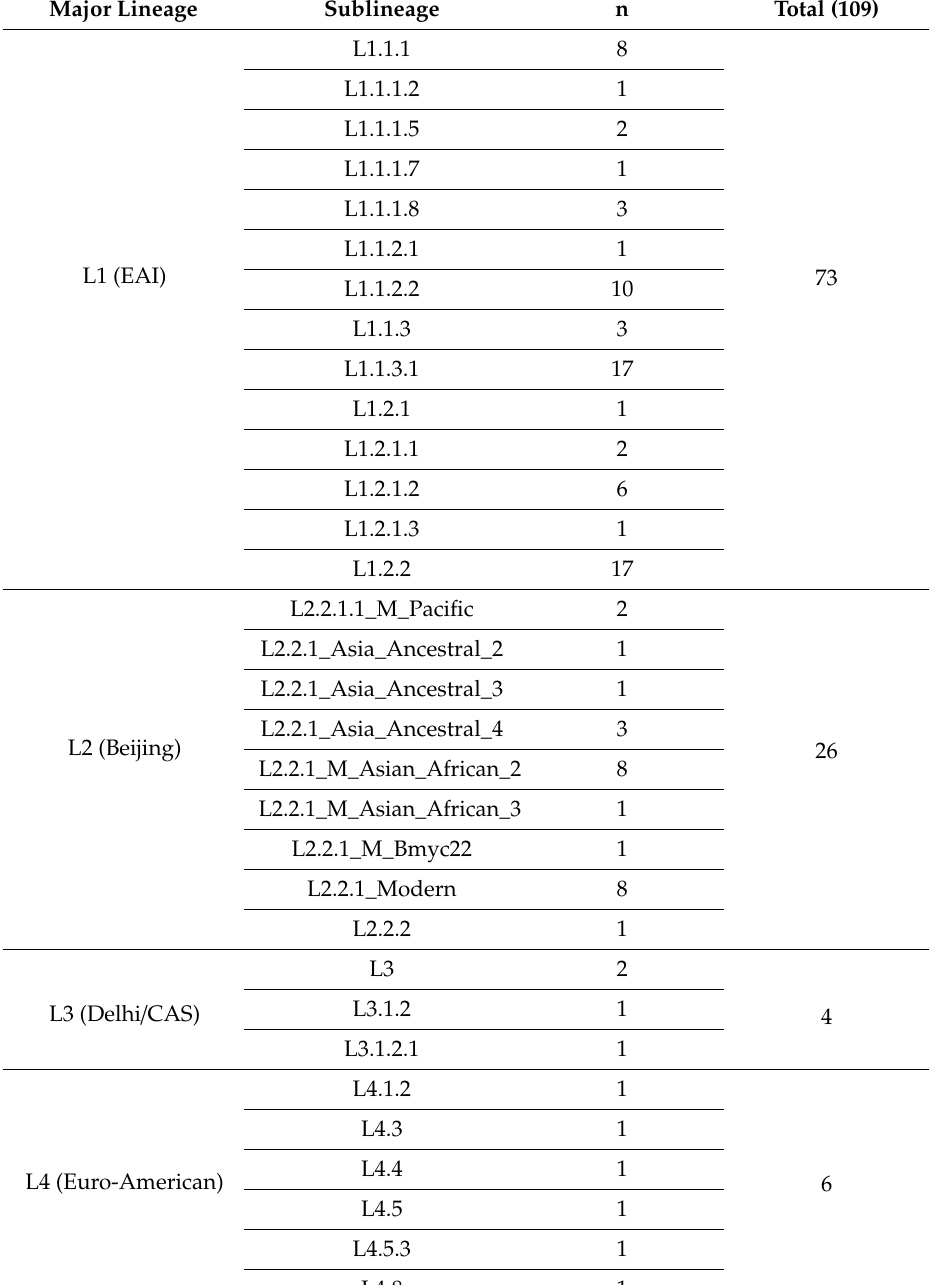
Table 2. Frequency Distribution of Major Lineages and